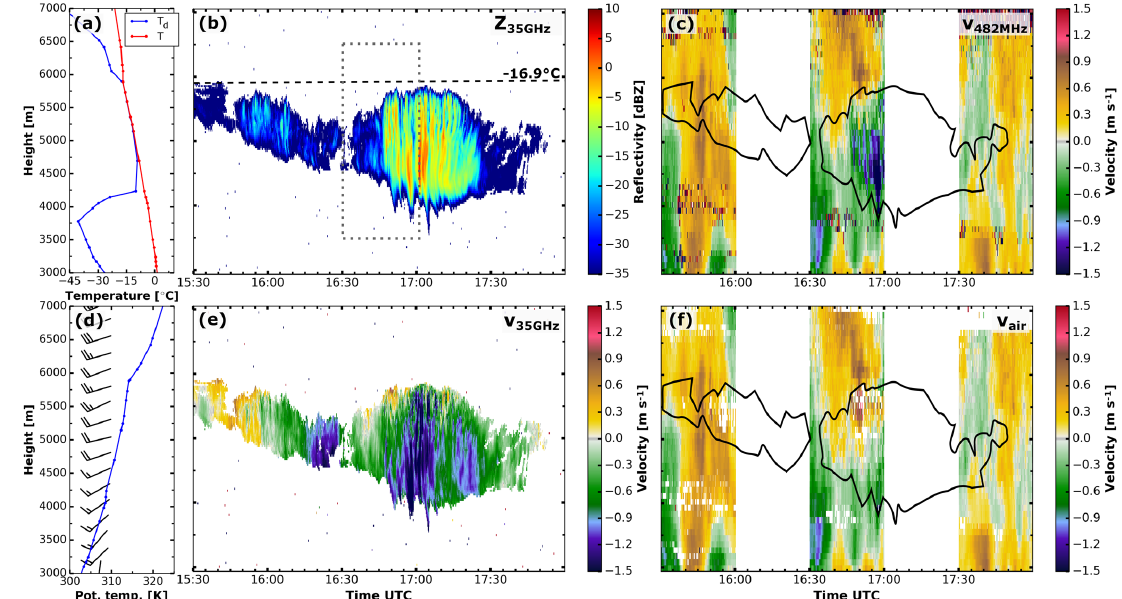
Figure 10. Mixed-phase layered cloud in the afternoon of 1 August 2015. Temperature T and dew point temperature T d (a) as well as potential temperature and wind profile from the 18 UTC radiosonde ascent. Cloud radar reflectivity (b) , vertical velocity retrieved with the standard RWP signal processing (c) , cloud radar vertical velocity (e) and the retrieved vertical air motion (f) . Values exceeding the velocity colour scale are shown in dark blue and red.